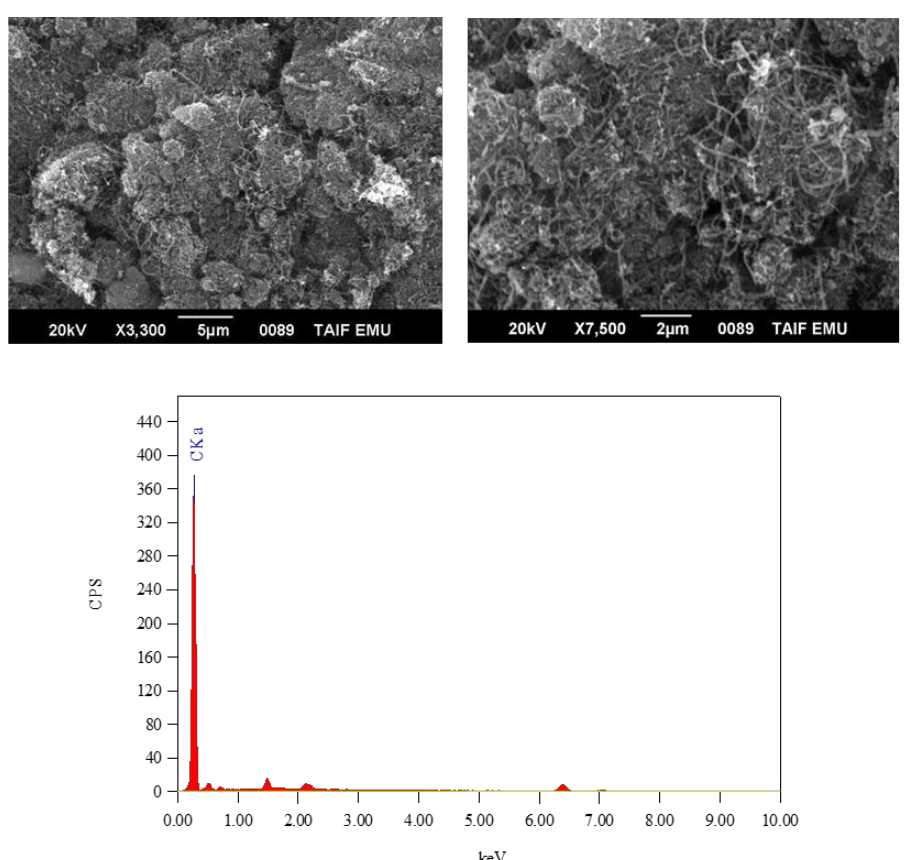
Figure 6. SEM images and EDX spectrum of the fullerene carbon nanotube (CNT).